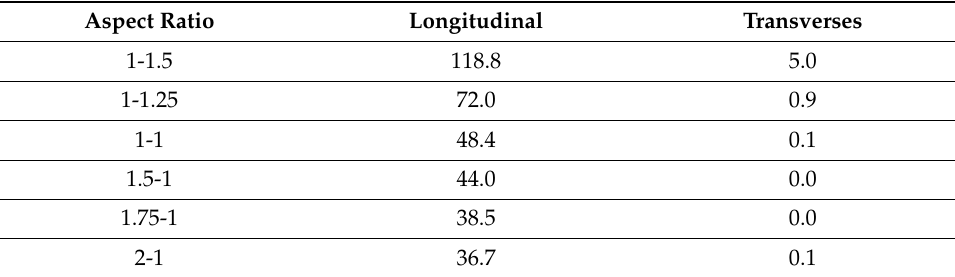
Table 2. Longitudinal and transverse stress at the 3 o’clock position for the different aspect